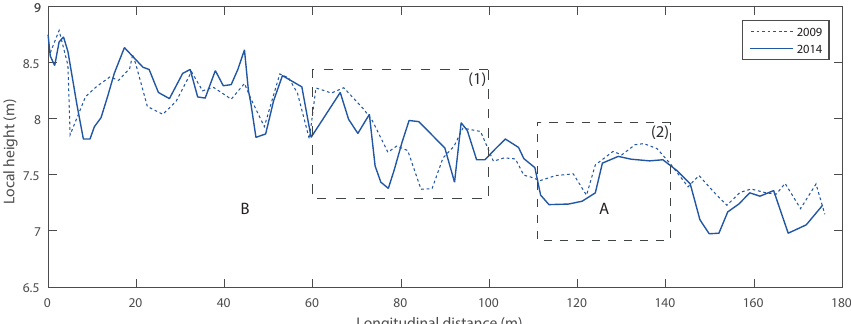
Figure 10. Comparison of long profile surveys of the channel diversion reach at Glaisdale Beck: 2 March 2009 to 7 April 2014. The dashed box labelled (1) shows the zone of lateral bank instability shown in Fig. 8. The dashed box labelled (2) represents the realigned section of the channel. (a) and (b) indicate the positions of the two main drop structures (weirs) on the river bed (locations also shown in Fig. 3).